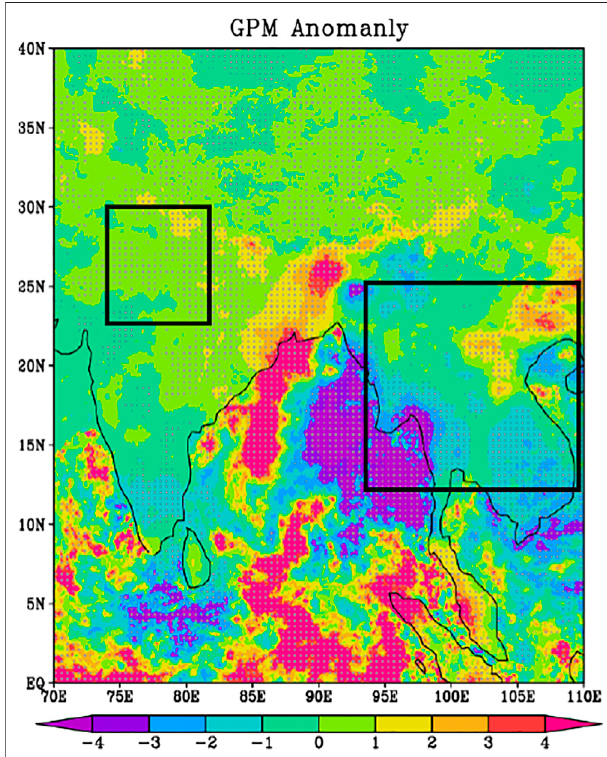
FIGURE 7 | GPM rainfall anomaly (2020-climatology) for the lockdown period of April-May. White dots indicate a 99% signi fi cance level. Boxes indicate North India and Myanmar regions.